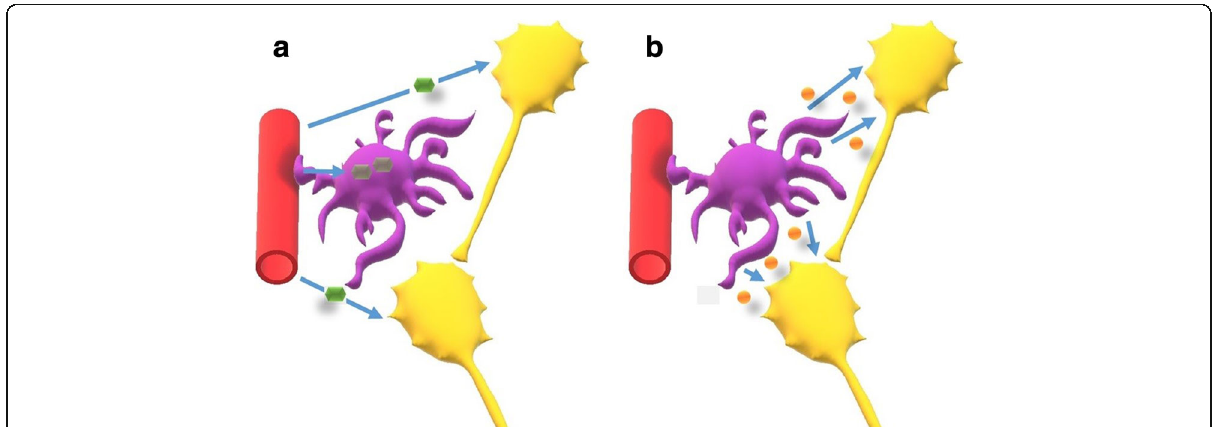
Fig. 4 Schematic representation of astrocytic (purple) and neuronal (yellow) metabolism at rest ( a , left) and upon stimulation ( b , right). Only astrocytes accumulate glucose (green) at rest, whereas upon stimulation, energetic reserves are degraded in order to provide energy substrates (lactate, orange) to neurons. Astrocytes in exchange reuptake exceeding glutamate at the synaptic cleft level (not shown). For details see ref.